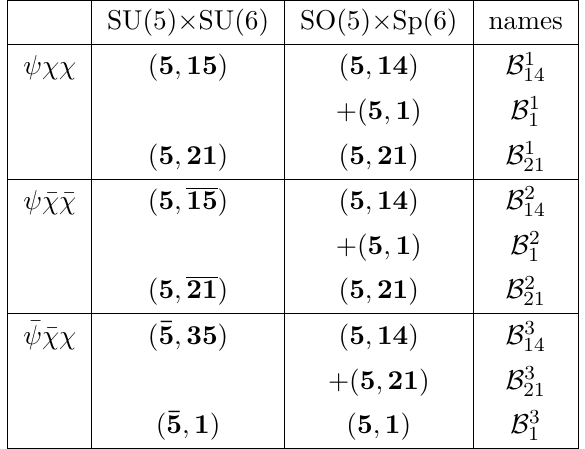
Table 2. Three-fermion bound states of the model and their quantum numbers with respect to the global flavor group and the unbroken